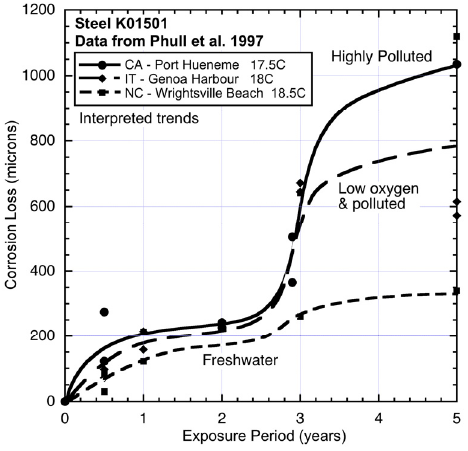
Figure 8. Corrosion loss data and trends for low alloy steel (type K01501) at CA, IT and NC showing effect of increasing pollution (nutrient) concentration in the seawaters. The freshwater contribution to the seawater at NC lowers the early corrosion losses. Data from [1].